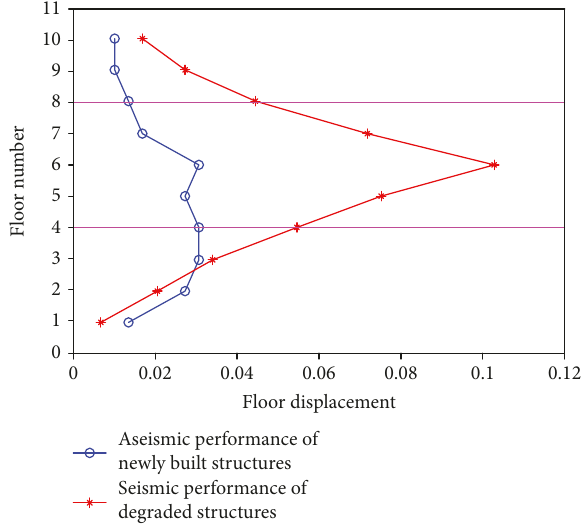
Figure 9: Floor displacement angle of di ff erent fl oors.